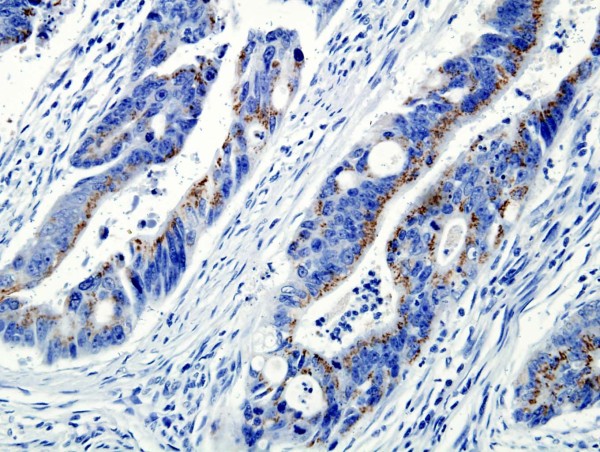
Expression of CD133 protein in gastric adenocarcinoma. CD133 predominantly localized in the membrane and cytoplasm around the lumen of cancerous glands in well-differentiated adenoocarcinoma (grade 1). (CD133 ×400).